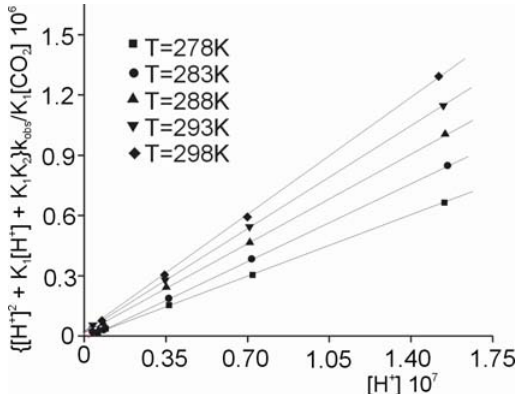
Table 2. Rate constants (k the carbon dioxide uptake by cis -[Cr(C ] = 0.01 M, I = 1 M, NaClO {[CO 2